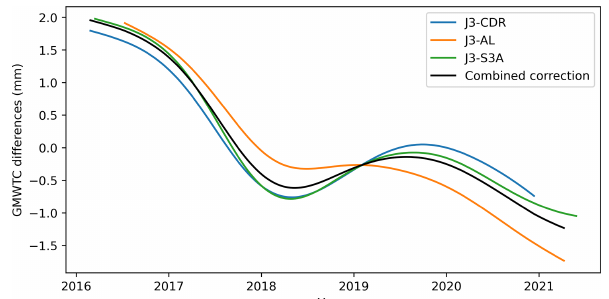
Figure 4. Differences between global mean wet tropospheric cor- rections (GMWTCs) from the Jason-3 (J3) microwave radiometer (MWR), derived from water vapour climate data records (CDRs), from SARAL/AltiKa (AL) MWR and from Sentinel-3A (S3A) MWR. The average (black curve) of these differences is used as empirical correction for the drift of the Jason-3